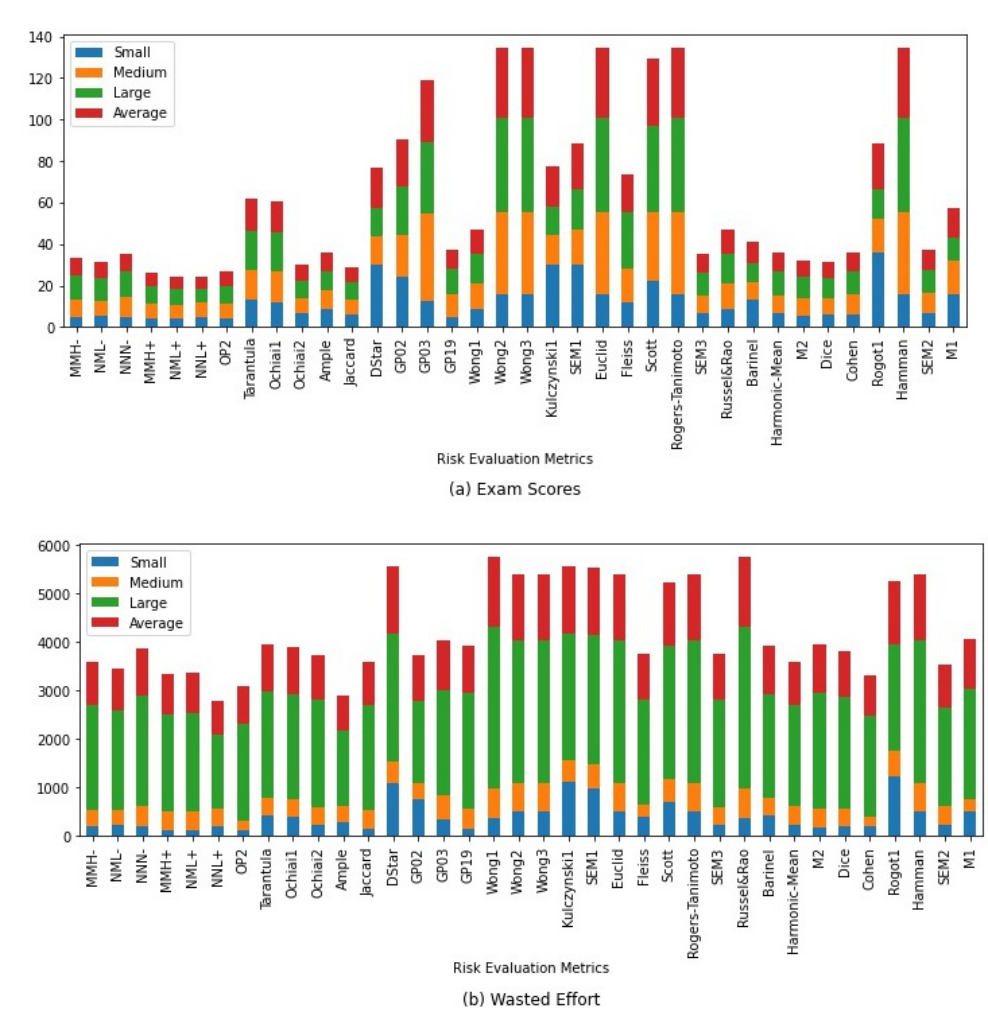
Figure 1. ( a ) shows the stacked bar-chart of Exam Scores of the combined and existing risk evaluation metrics. ( b ) shows the wasted effort computed by the combined and existing risk evaluation